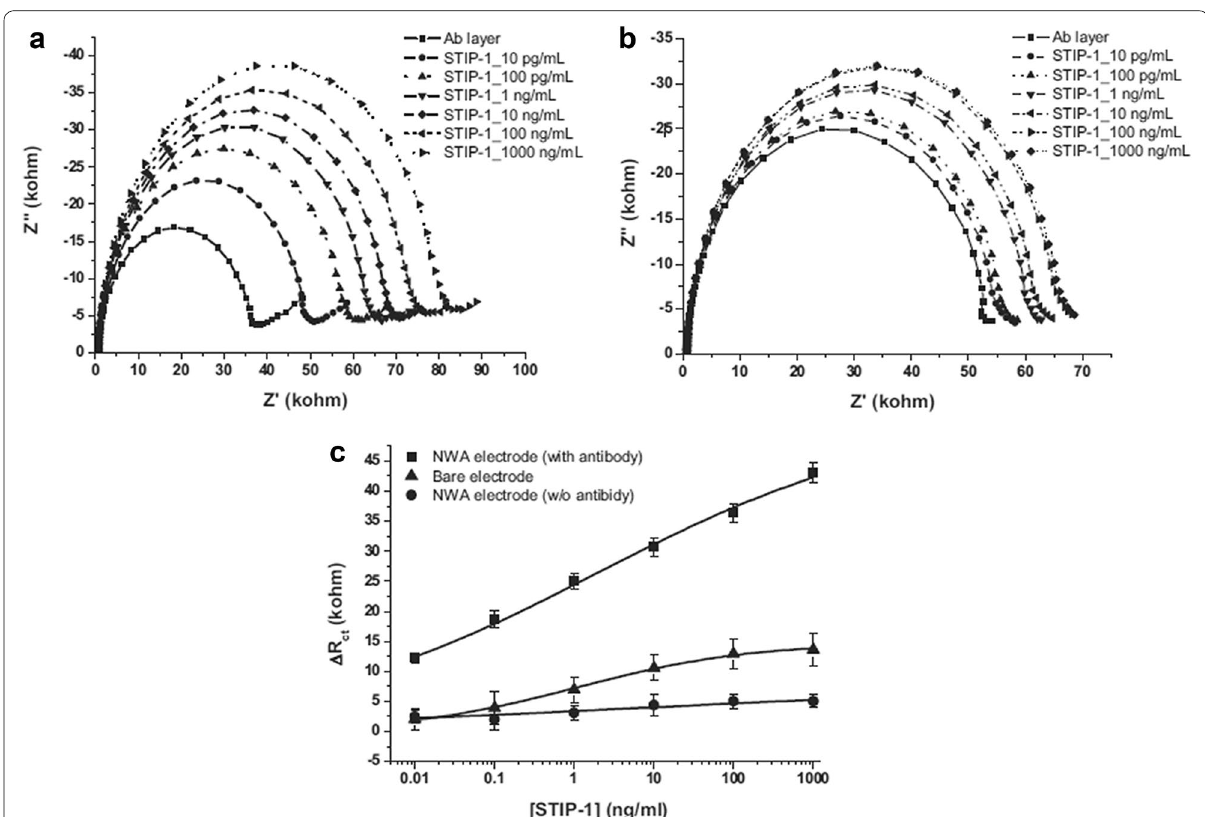
Fig. 15 EIS binding of STIP-1 to the immunolayer on the electrodes. a Nyquist plot for the NWA electrode. b Nyquist plot for the bare electrode. c Quantitative analysis of STIP-1 and anti-STIP-1 antibody binding on the NWA and bare electrodes